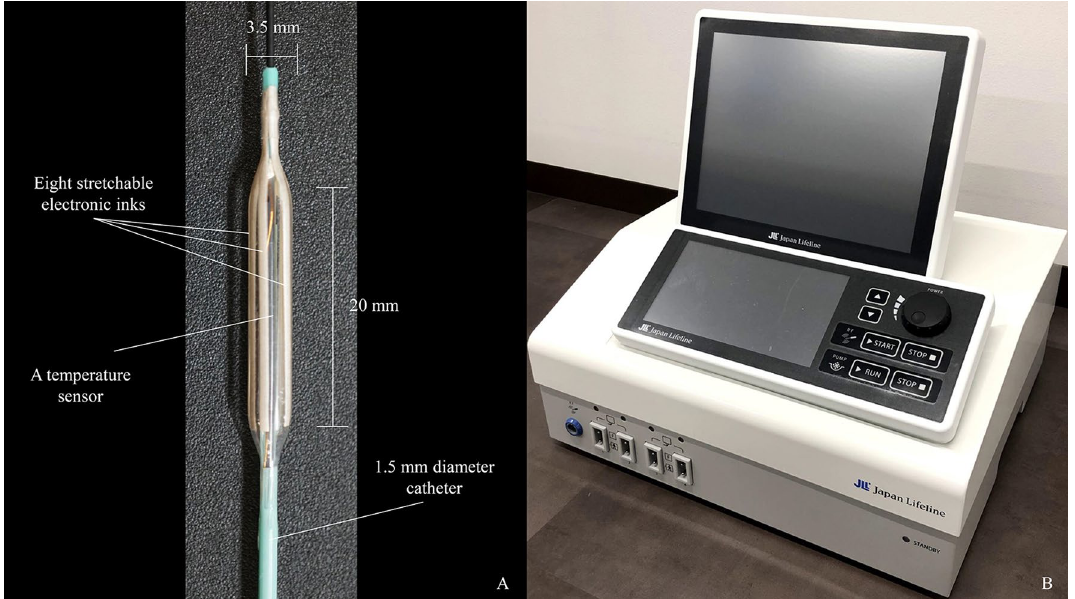
Figure 1. ( A ) Prototype balloon-based radiofrequency ablation catheter, which is ultrathin (1.5-mm diameter) to enable insertion through the working channel of a cholangioscope. It has a 3.5- or 6-mm-diameter balloon at the tip, eight stretchable electronic inks printed along the balloon’s length, and a temperature sensor at the surface of the balloon. ( B ) The generator can monitor temperature, power status, and impedance during the procedure in